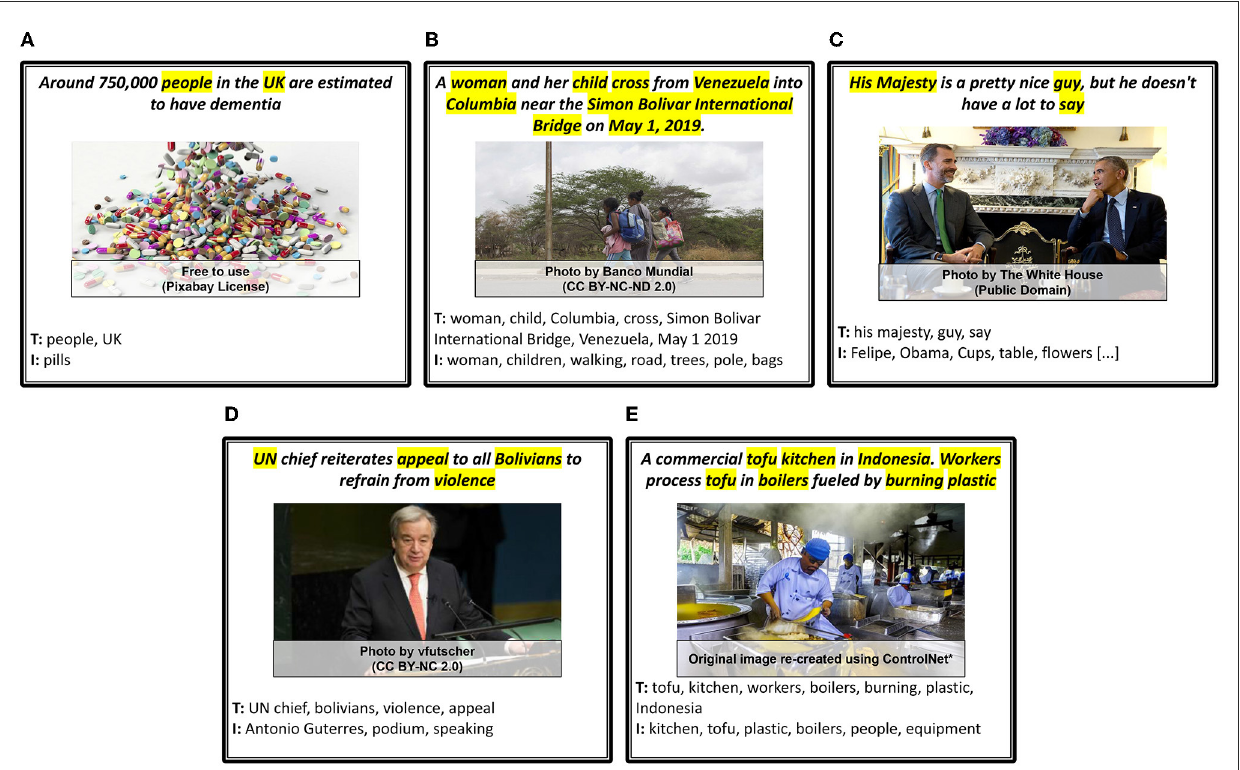
FIGURE6 News articles annotated with the sub-categories of Objective relations . Each sample includes the identified textual ( T ) and visual ( I ) concepts, entities, etc., along with the assigned sub-categories of Objective Overlap (OO) and Objective Extension (OE) . *Used ControlNet (Zhang and Agrawala, 2023) to re-create images because of licensing issues. (A) OO: Uncorrelated, OE: No Extension. (B) OO: Partial Ovelap, OE: Both Extend. (C) OO: High Overlap, OE: Image Extends Text. (D) OO: Partial Overlap, OE: Text Extends Image. (E) OO: High Overlap, OE: Both Extend.